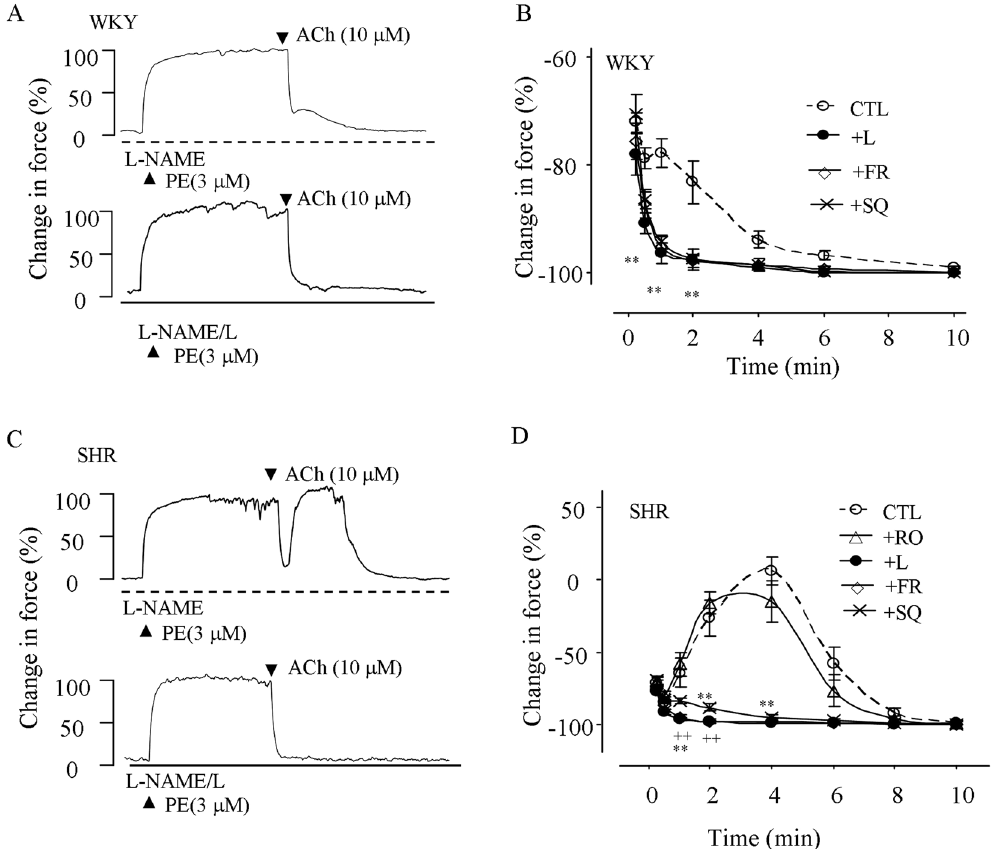
Figure 5. ACh-evoked responses in NOS-inhibited rat mesenteric resistance arteries precontracted with PE. ( A ) Representative traces showing the control response (CTL) evoked by ACh (10 μ M; top) in L-NAME-treated WKY vessels precontracted with PE (3 μ M) and that obtained with the EP antagonist L798106 (1 μ M; + L; bottom). ( B ) Summary of results from 5 replicates in ( A) , and those obtained with the TP antagonist SQ29548 (10 μ M; + SQ) or the COX-1 inhibitor FR122047 (1 μ M; + FR). ( C ) Representative traces showing the control response (CTL) evoked by ACh (top) in PE-precontracted, L-NAME-treated SHR vessels and that obtained with L798106 ( + L; bottom). ( D ) Summary of results from 5 replicates in ( C ) and those obtained with SQ29548 ( + SQ), FR122047 ( + FR), or the COX-2 inhibitor rofecoxib (1 μ M; + RO). In ( B ) and ( D ), ** P < 0.01 vs. CTL while ++ P < 0.01 vs. +